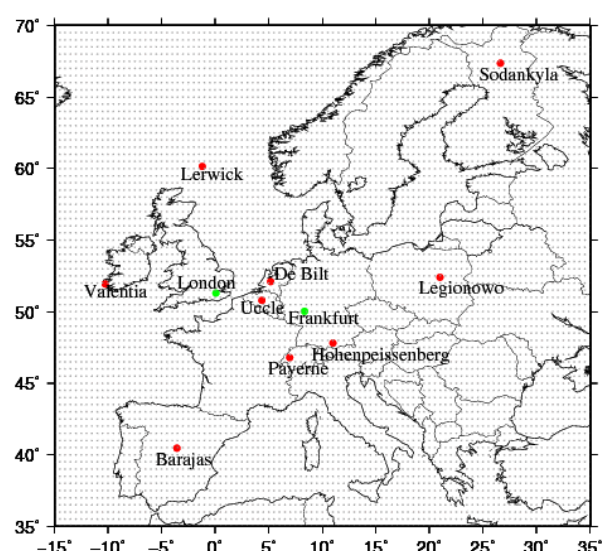
Fig. 1. Measurement sites of ozone profile over Europe. Red circles denote the location of balloon sounding sites. Green triangles indi- cate airports used under the framework of the MOZAIC program for summer 2008. Also indicated, are the centres of the horizontal grid (with 0.5 ◦ resolution) on which output from different models is